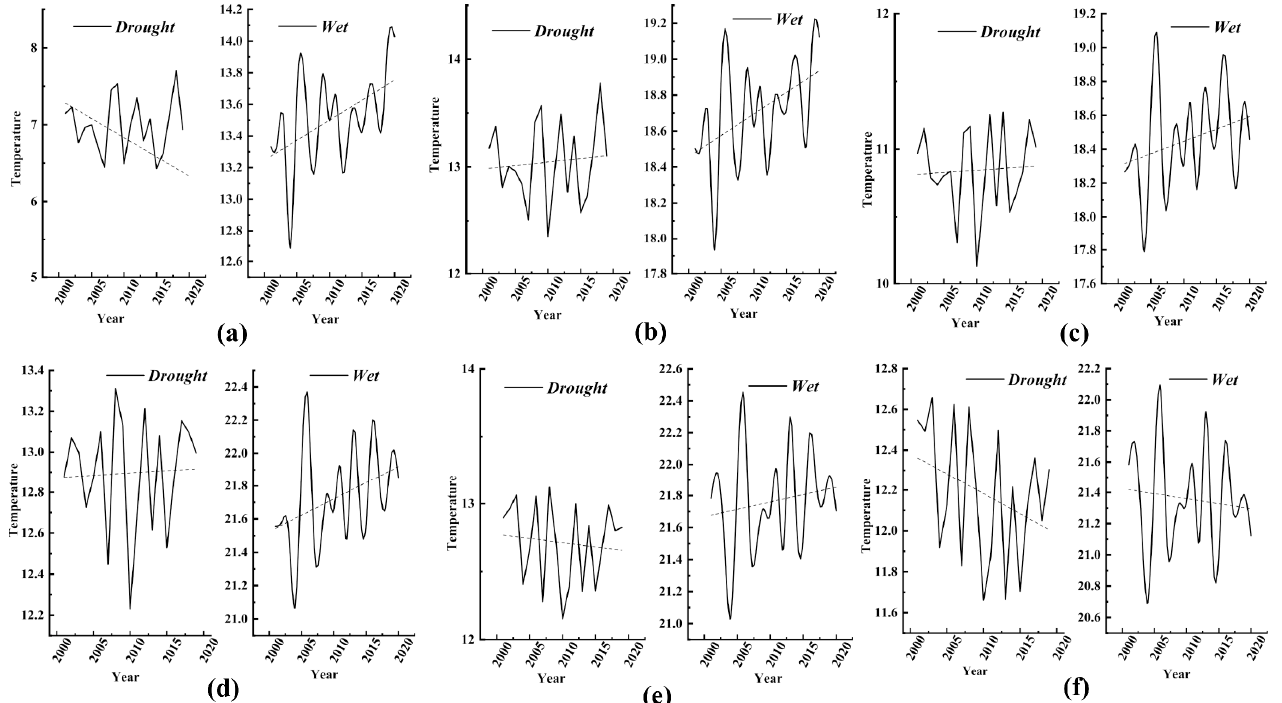
Figure 13. Characteristics of the drought and wet season variation in temperature (°C). ( a ) Lugu Lake; ( b ) Qionghai Lake; ( c ) Ma Lake; ( d ) Three Forks Lake; ( e ) Luban Reservoir; ( f ) Shengzhong Reservoir. Note, the direction of the dashed line indicates the trend of temperature in the drought and wet season.